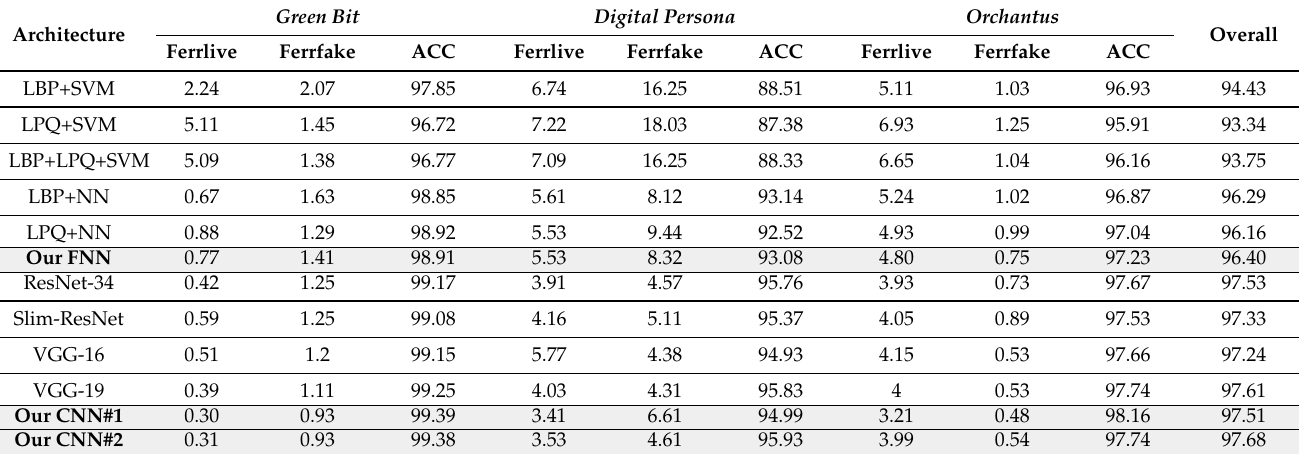
Table 4. The performance comparison between different architectures: accuracy.